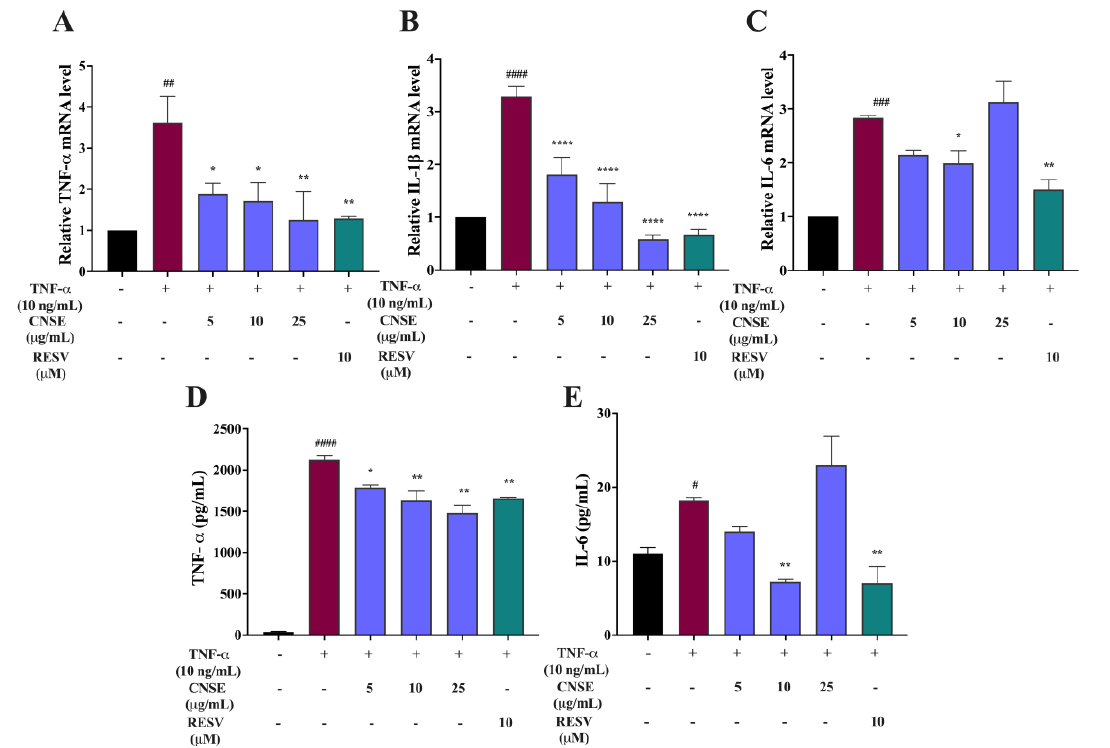
Figure 7. Inhibitory effects of CNSE on the expressions of proinflammatory cytokines’ production in BV-2 cells. The mRNA levels of inflammatory cytokines were measured after treatment of cells with CNSE for 24 h, followed by TNF-α for another 3 h using real-time PCR. RESV was used as a positive control. The relative expression, as shown by fold changes in ( A ) TNF- 𝛼 , ( B ) IL-1β, and ( C ) IL-6, was normalized with the internal control, β-actin. The release of cytokines, including ( D ) TNF- 𝛼 and ( E ) IL-6, was also measured using commercial ELISA kits. The concentrations of protein levels (pg/mL) in the cell culture medium after CNSE and TNF- 𝛼 treatment for 24 h were calculated by comparing them to the standard curve. Black color represents untreated control, red color represents TNF-α group, violet color represents CNSE treatment and green color represent RESV treatment. Data are represented as the mean ± SD from at least three independent experiments. A p-value < 0.05 was considered to show a significant difference between each group ( #### p < 0.0001; ### p < 0.001; ## p < 0.01; # p < 0.05 vs. untreated control; **** p < 0.0001; ** p < 0.01; * p < 0.05 vs. TNF- 𝛼 -treated group).